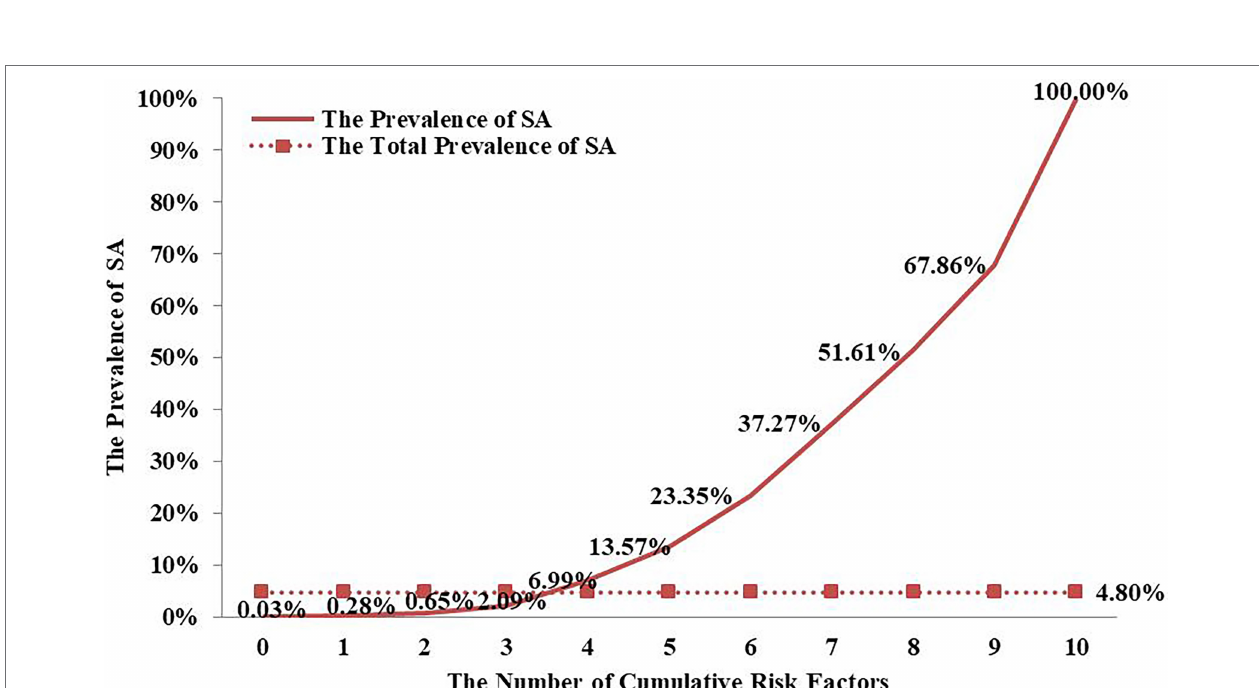
FIGURE 3 | SA risk among Chinese adolescents from Grade 8 to 12 under different Cumulative risk